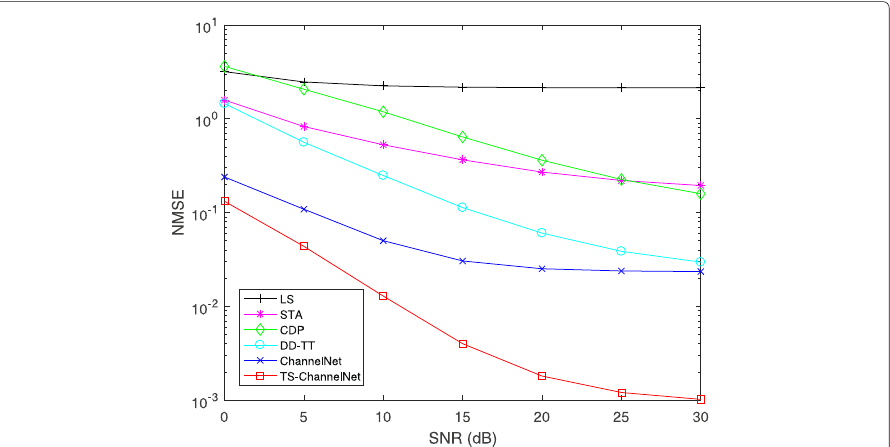
Fig. 2 NMSE with 4QAM modulation, maximum Doppler = 1200 Hz, and 60 OFDM symbols (VTV Expressway